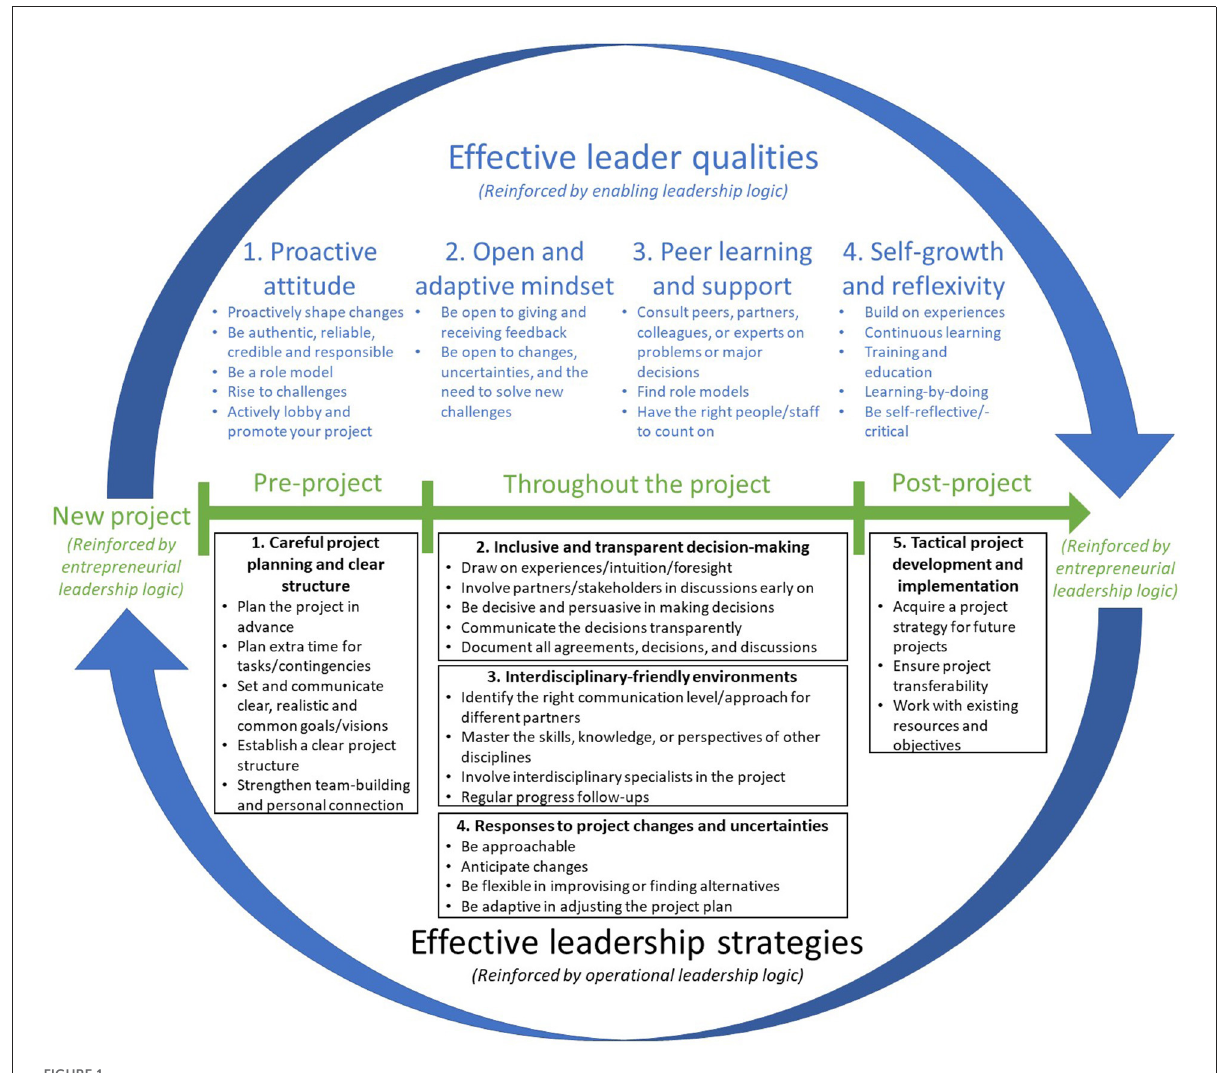
FIGURE1 Effective CAHP project leaders(hip)